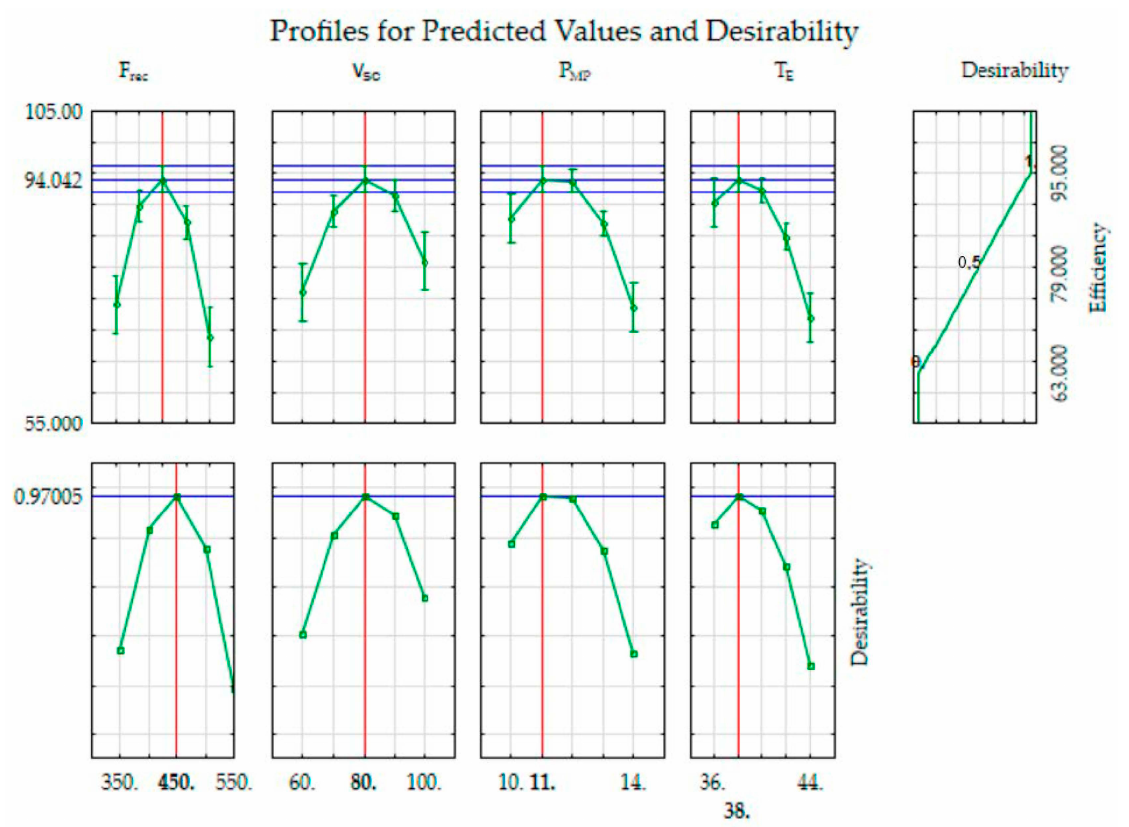
Figure 6. Profiles of individual ( left ) and global ( right ) desirability of the conditions established for the experiments carried out in the semi-industrial IPST analysis.